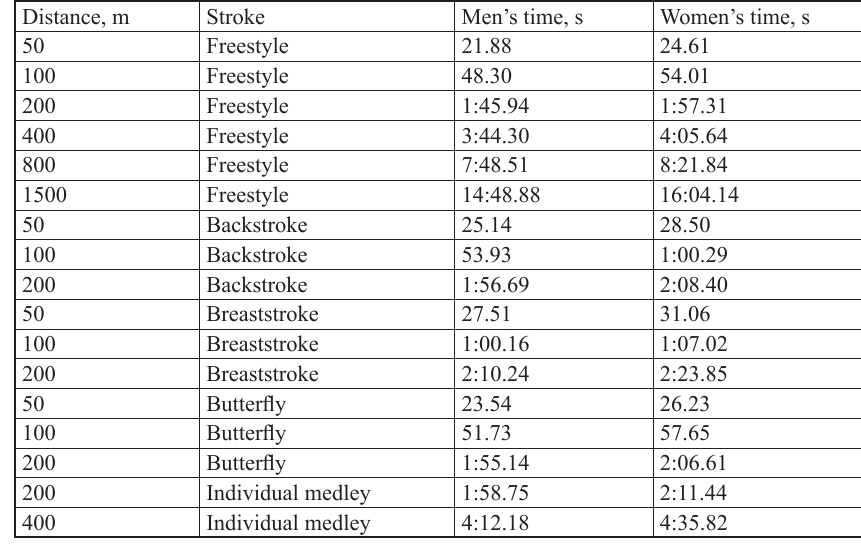
Table 6. European Masters Swimming Championship 50 m freestyle champions’ (women) results (2007) before and after indexing Age groups, year interval Of fi cial time, s Rank according time Coef fi cient Indexed time, s Places after indexing Table 7. Lithuanian Master Swimming Championship Top-10 swimmers Place Gender Stroke